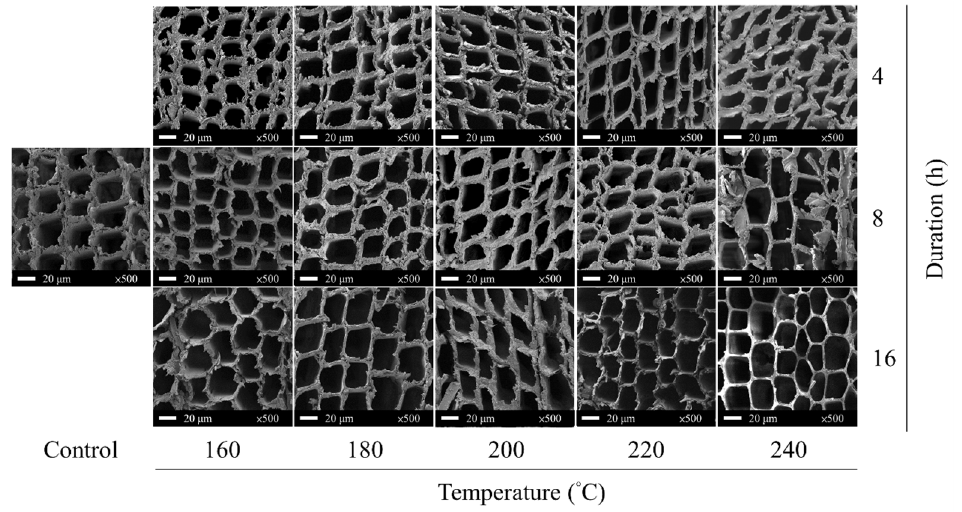
Figure 1. Cross-sectional SEM of untreated (control) and VH-treated luanta fir